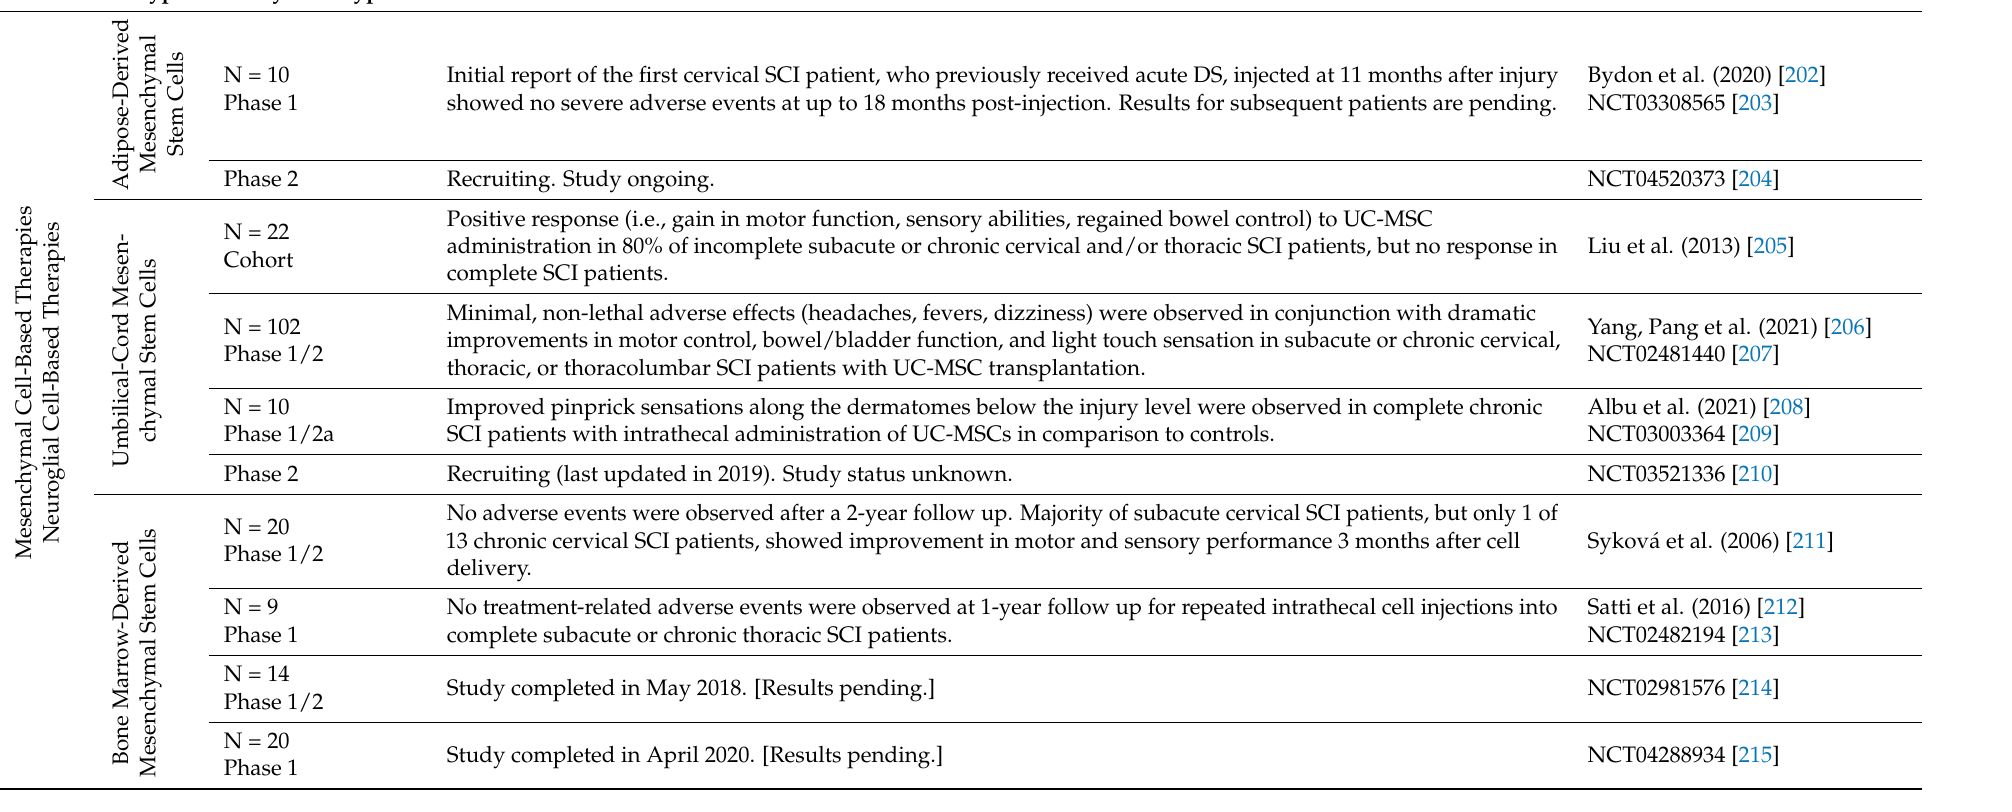
Table 3. Clinical Studies of Cell-Based